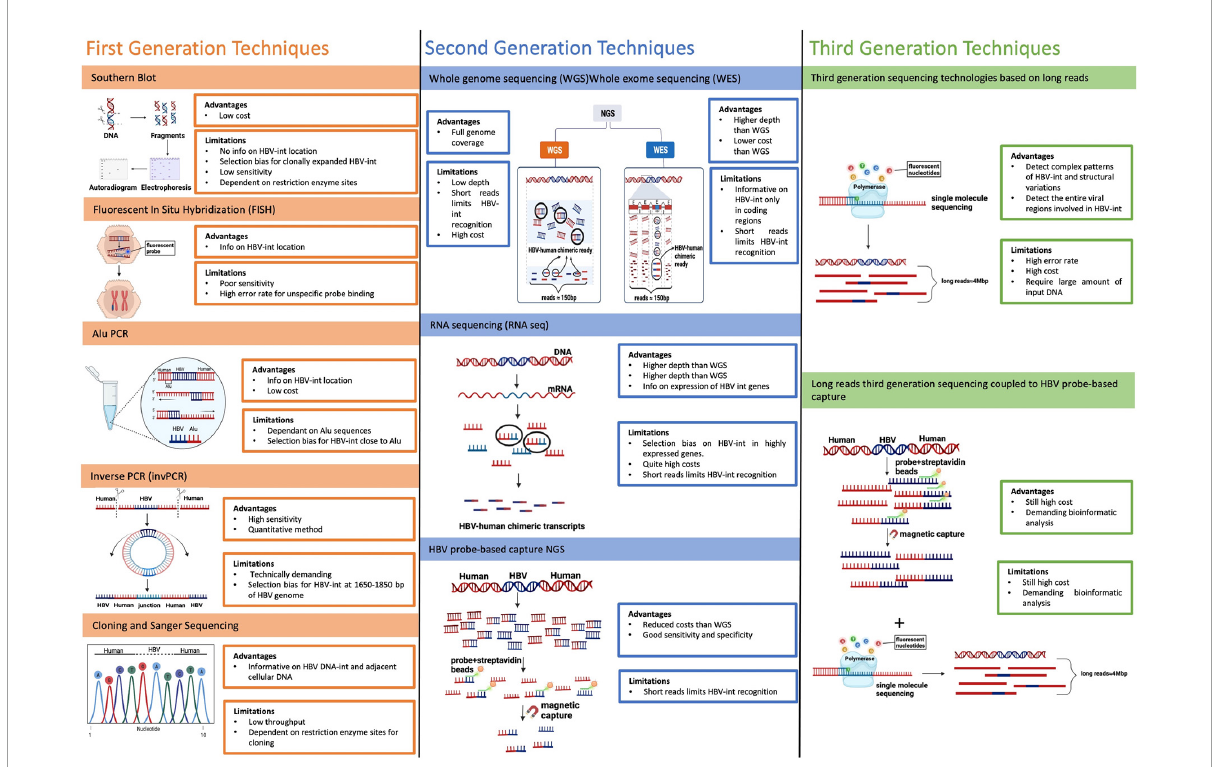
FIGURE5 Main techniques utilized to detect HBV-DNA integration. The figure reports an overview of the first-, second-, and third- generation techniques utilized to detect HBV-DNA integration into human genome with their main advantages and limitations. First generation techniques include: Southern Blot, Fluorescent In situ Hybridization (FISH), Alu PCR and Inverse PCR (invPCR). Second-generation techniques are based on Next-generation sequencing (NGS) and are based on short reads (with a length of 150 base pair in most used NGS platform). They include: whole-genome sequencing (WGS), whole-exome sequencing (WES), and RNA sequencing (RNA-seq). Third-generation techniques rely on the use of long-read sequencing, a technology based on single-molecule sequencing without pre-PCR amplification, producing long-reads (up to 4 Mbps) in a real-time sequencing